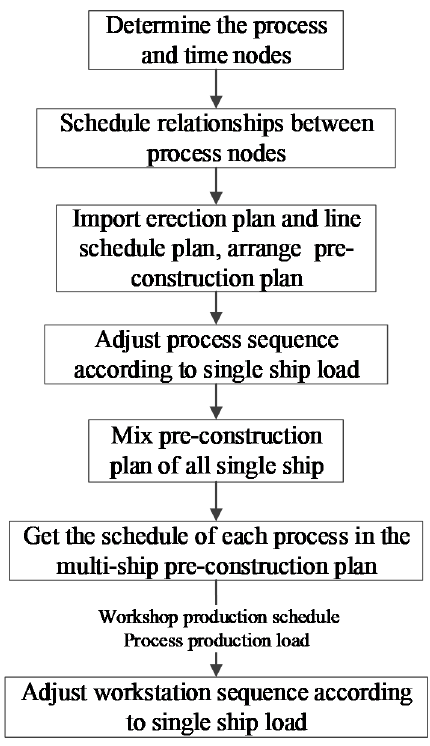
Figure 1. Pre-construction plan process.